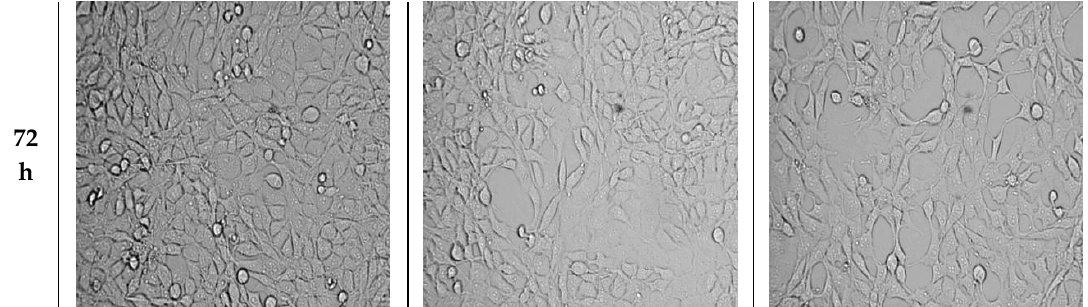
Figure 8. The effect of S-TPU and F-TPU filament extracts on the cellular morphology of mouse embryonic fibroblast NIH 3T3 cells.